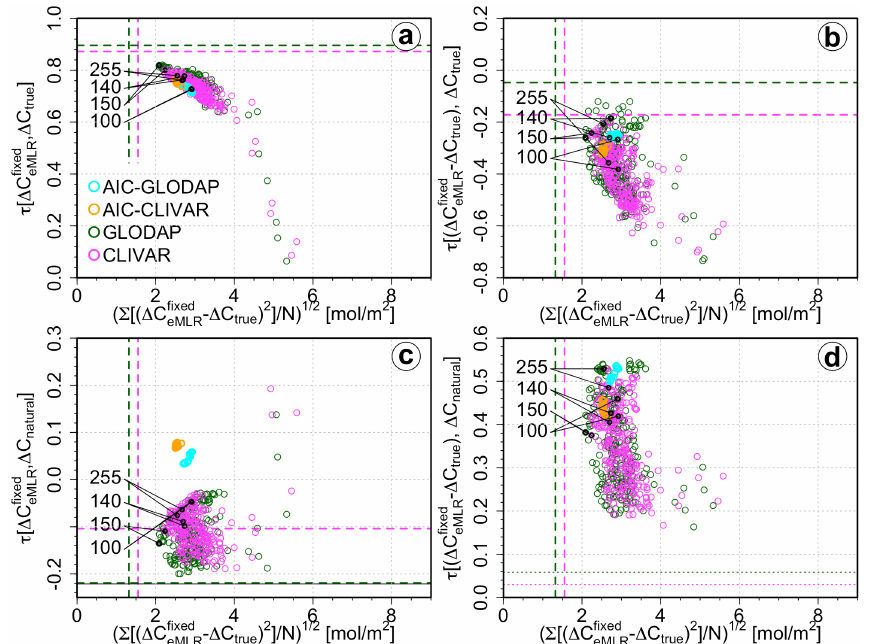
Fig. 15. Same as Fig. 14 when sampling networks are held fixed in time ( 1C fixed